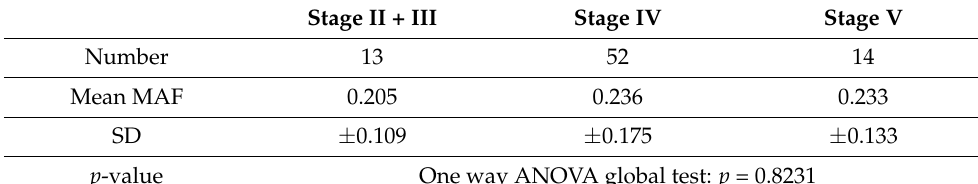
Table 5. A comparison of the MAF values in different stages.